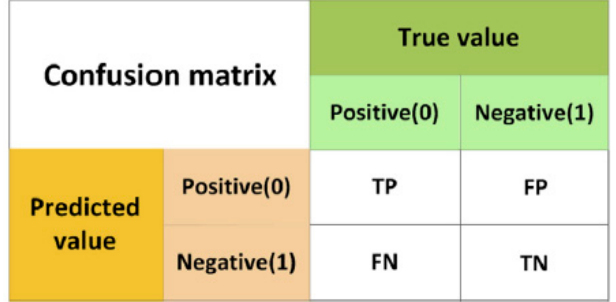
Figure 4. The confusion matrix of binary classification.